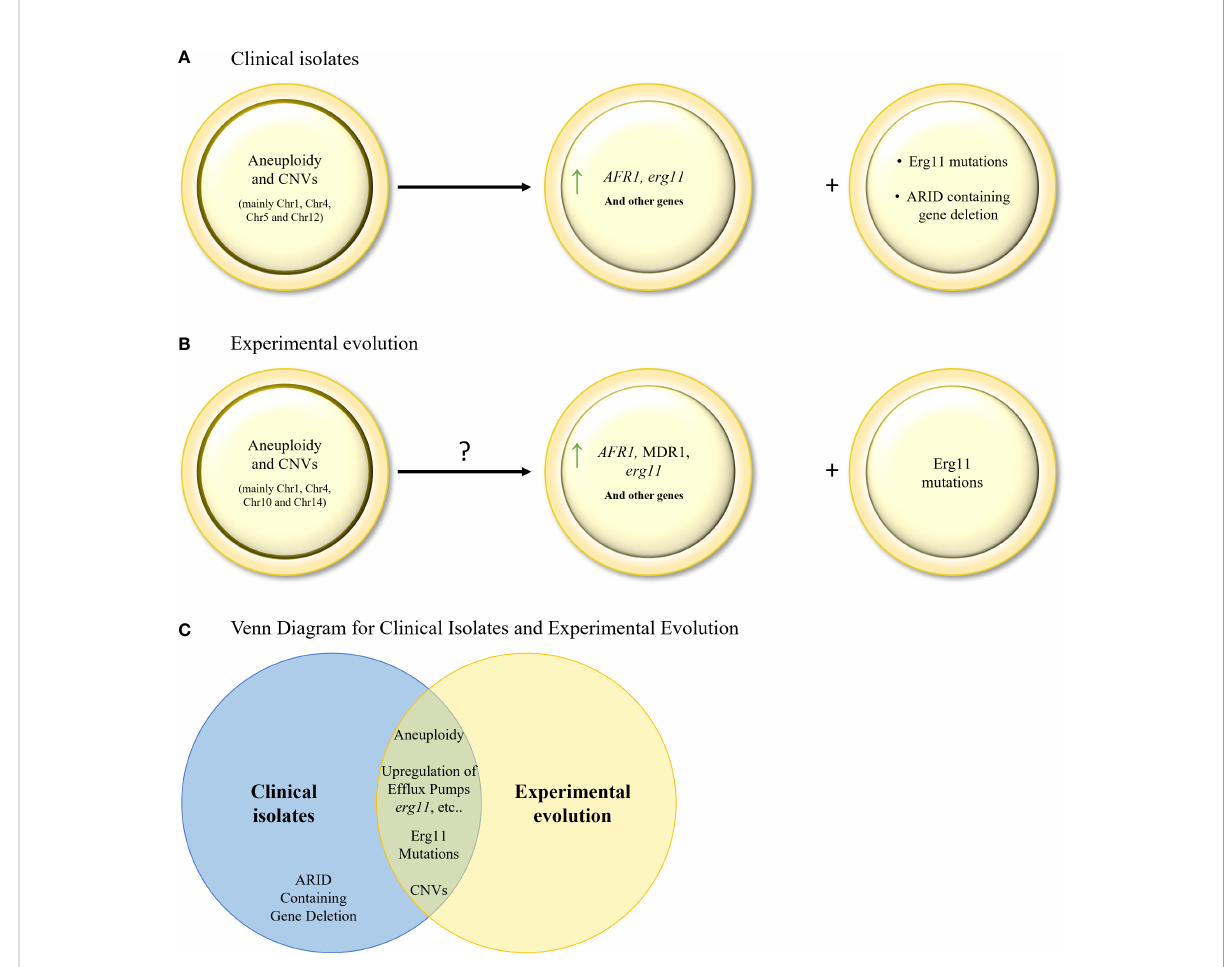
FIGURE 3 (A) . Evolution of triazole resistance in serial clinical isolates of C neoformans . Aneuploidies and CNVs in key chromosomes, leading to gene ( AFR1 and ERG11 ) overexpression, are the main drivers of triazole resistance in C neoformans . ERG11 mutations and ARID containing gene deletion are also found, but to a lesser extent. (B) Mechanisms of triazole resistance identi fi ed in in – vitro evolution isolates of C neoformans and C gattii . Aneuploidies and CNVs in key chromosomes, leading to gene overexpression, have been identi fi ed. ERG11 mutations were also found but to a lesser extent. (C) Venn diagram of azole resistance mechanisms in serial clinical isolates and in in – vitro evolution in C neoformans and C gattii isolates. Aneuploidy, upregulation of ef fl ux pumps, upregulation and mutations in ERG11, and CNVs are common to both evolutionary tracks.